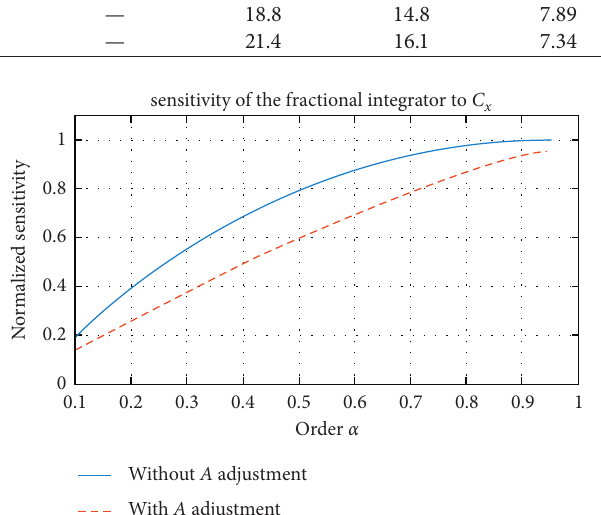
Figure 9: Normalized sensitivity of F ( s ) regarding C